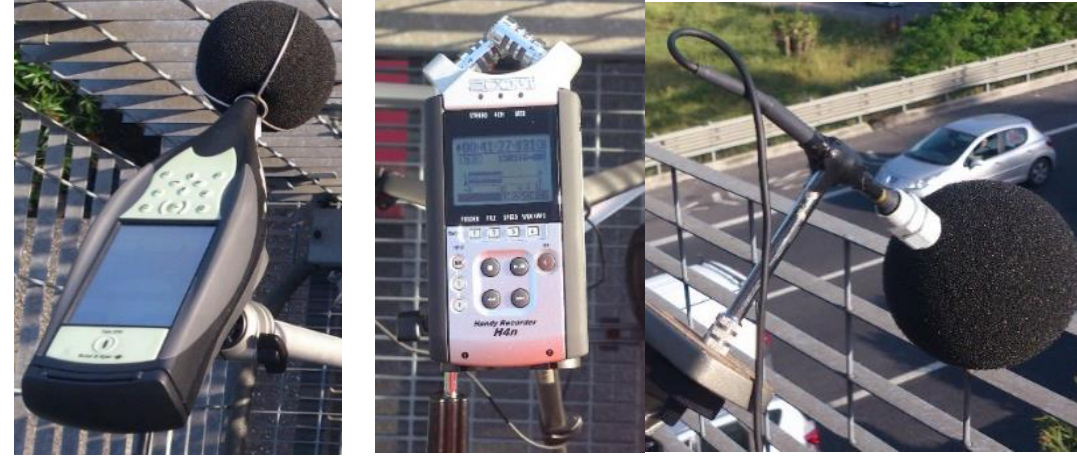
Figure 9: Recording equipment [30].